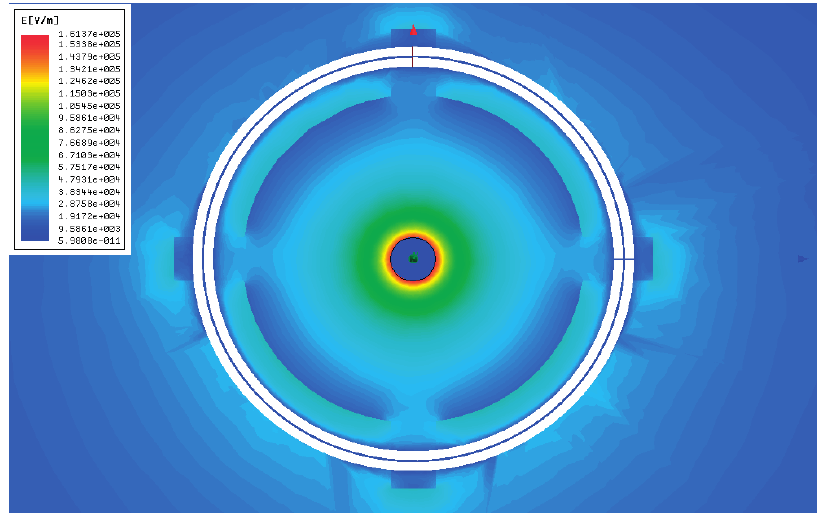
Figure 8. Electric field distribution of D-dot probe.